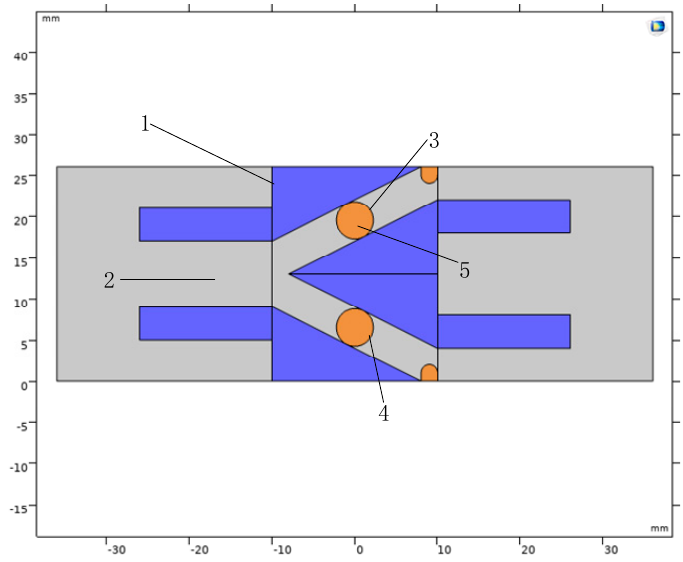
Figure 3. Two - dimensional model. Figure 3. Two-dimensional